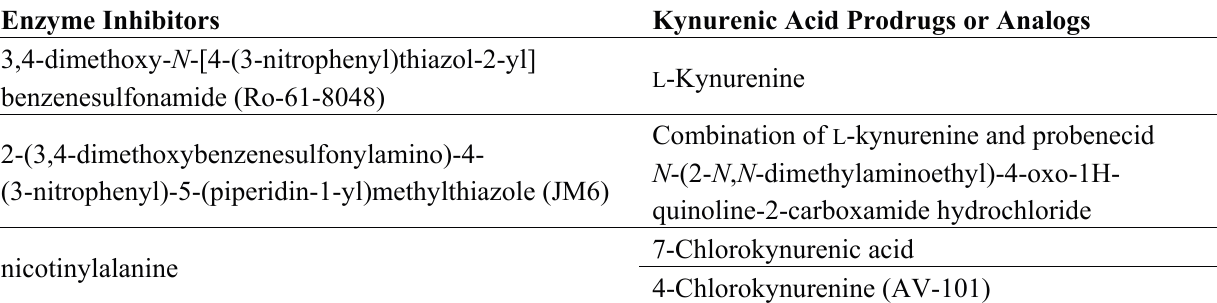
Table 2. Therapeutic options for modulating the kynurenine pathway in neurodegenerative diseases, with some of the candidates developed and tested so